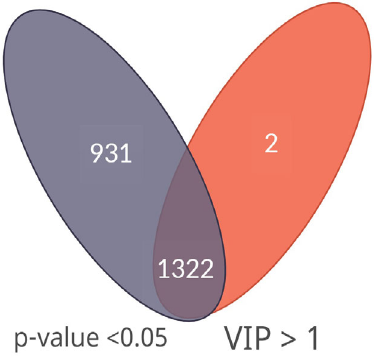
Figure 1. Selection of the most discriminatory m/z peaks to further analysis. The Venn diagram demonstrates the number of detected peaks common for two statistical approaches (Variable importance for the Projection (VIP) and Wilcoxon rank-sum test using False Discovery Rate (FDR) corrected p ‐ values).